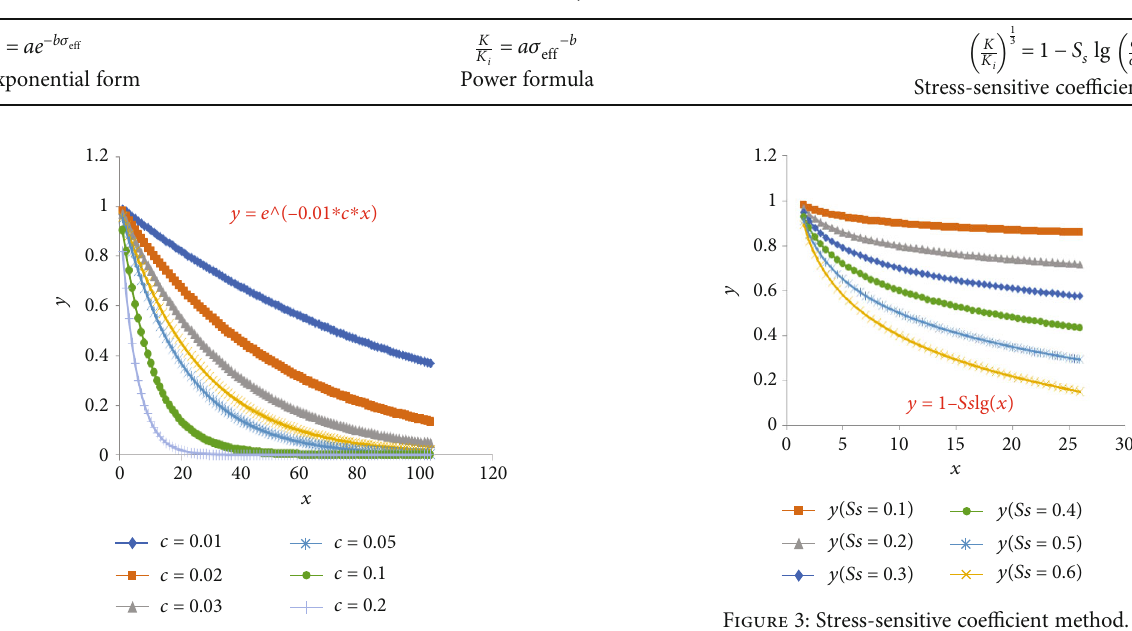
Table 1: Permeability characterization method.